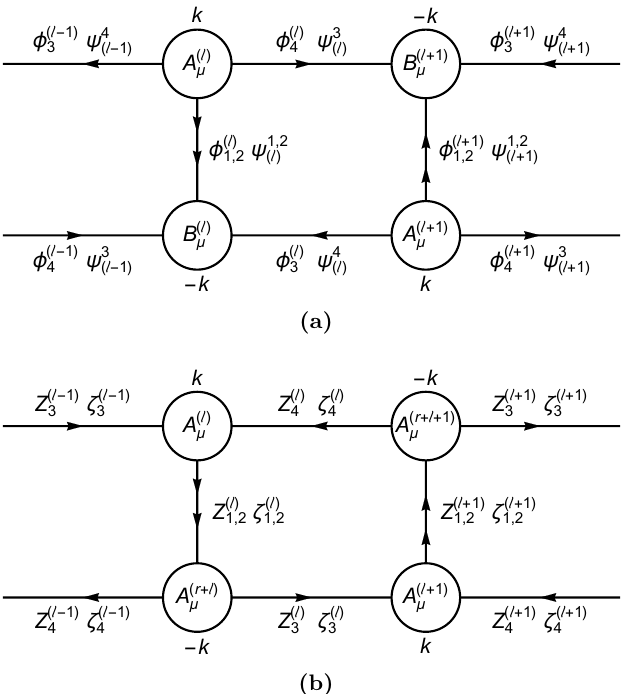
Figure 2. The quiver diagram of N = 2 orbifold ABJM theory in (a) ABJM notation and (b) N = 2 notation. We have omitted the complex conjugates of the matter